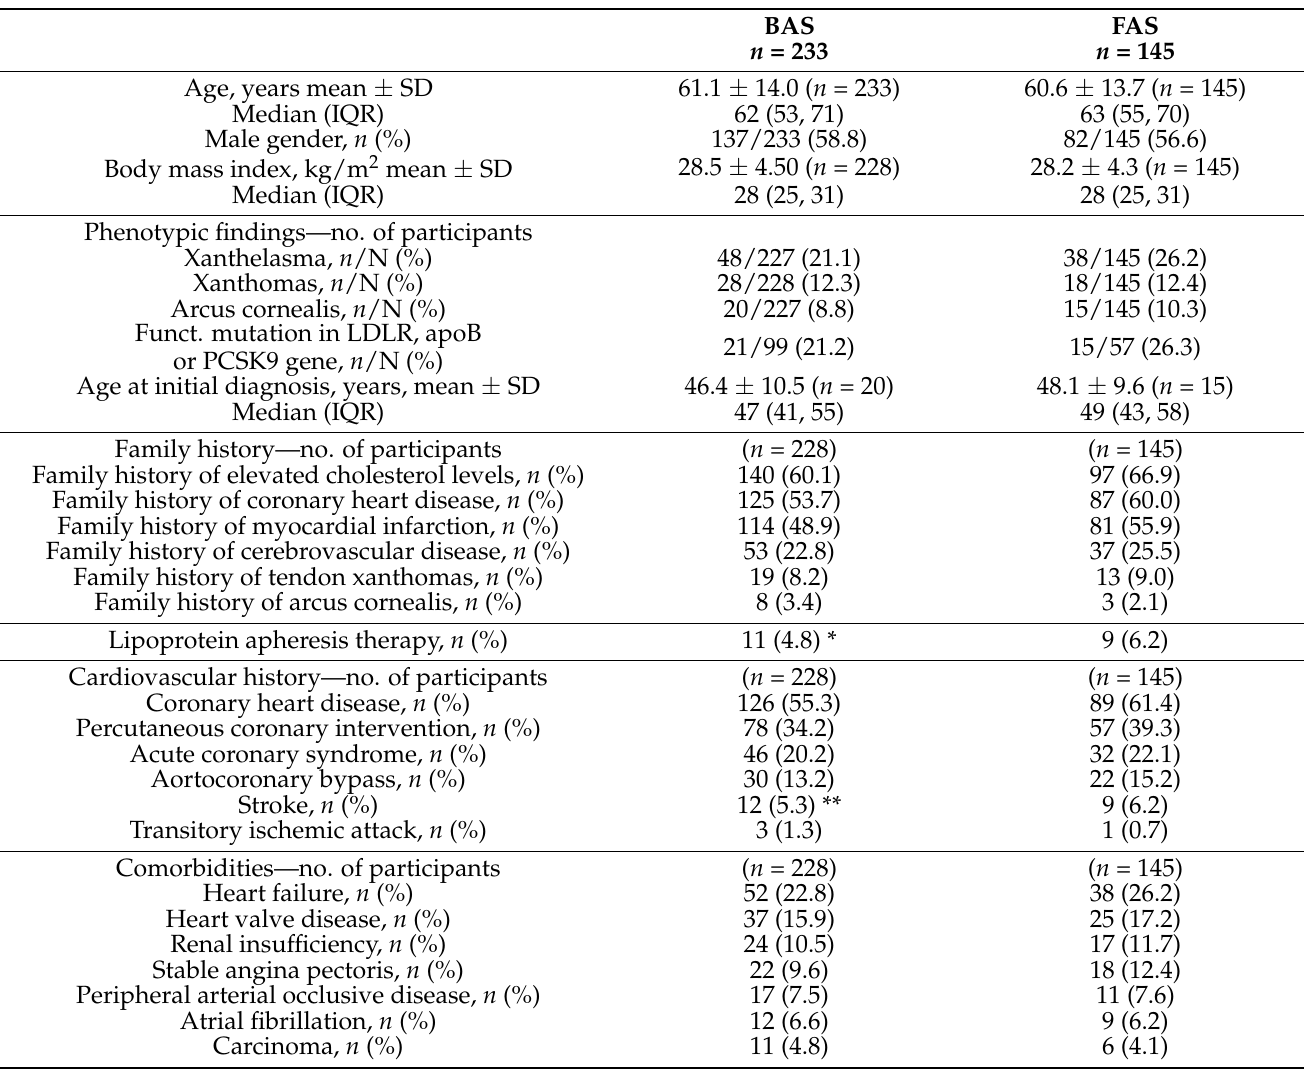
Table 1. Patient characteristics for the BAS and FAS.